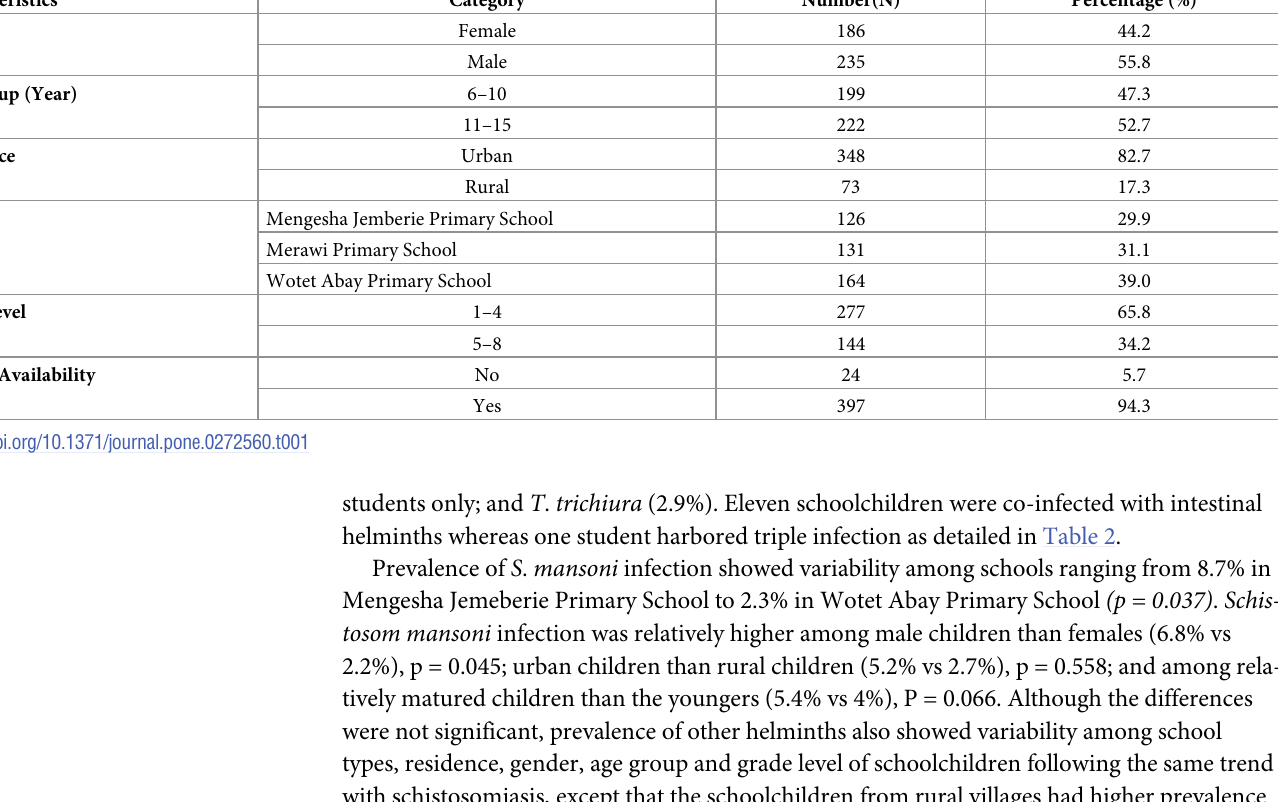
Table 1. Socio-demographic characteristics of the study participant schoolchildren in northwest Ethiopia, n = 421. Characteristics